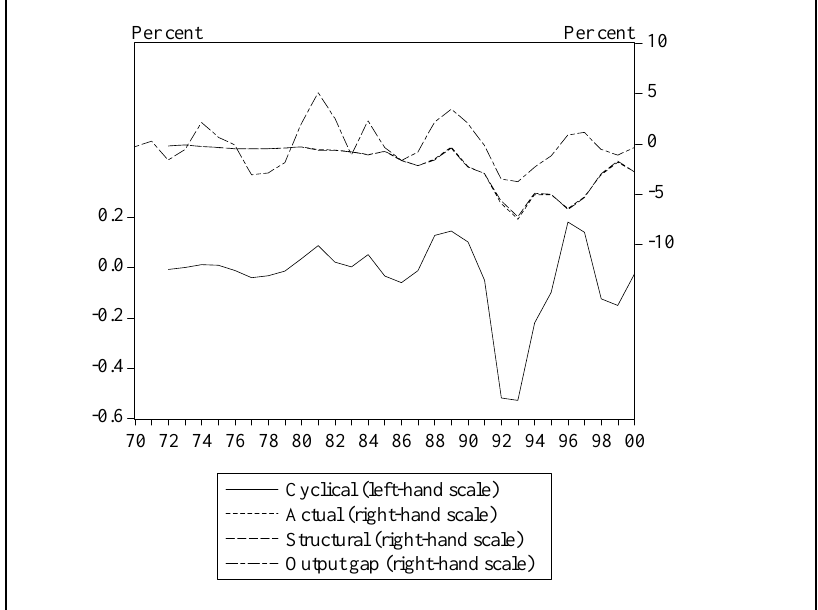
Comparison of the actual, structural and cyclical components of the budget balance against the output